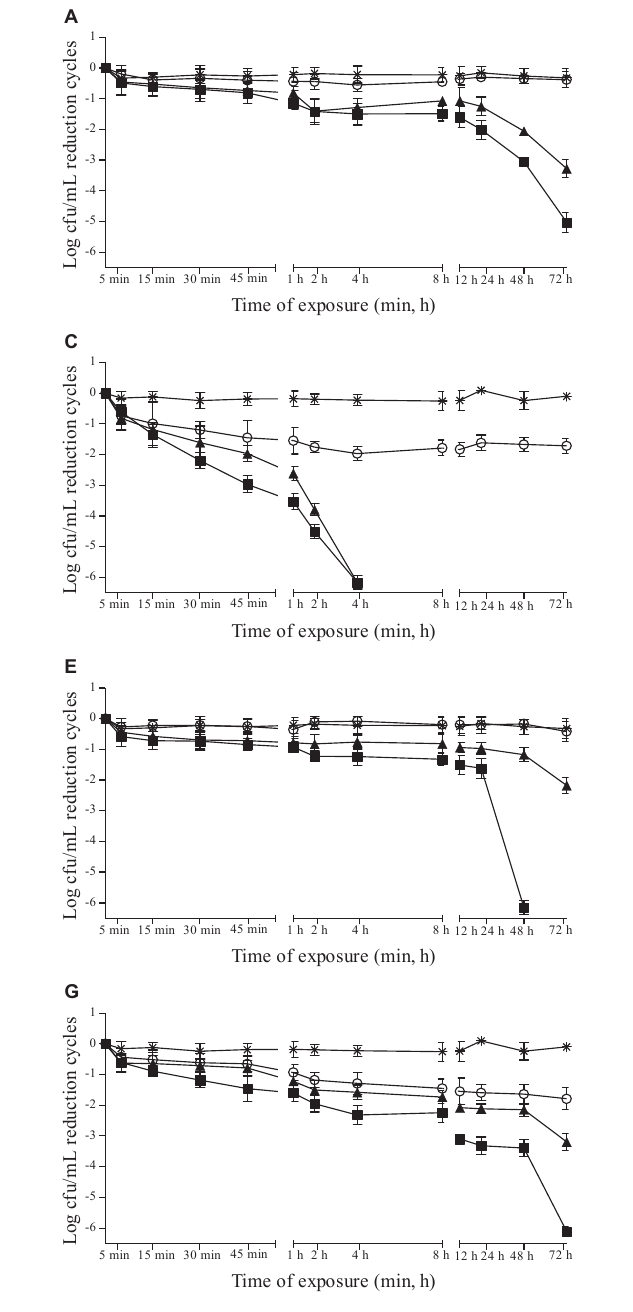
FIGURE 3 | Reduction cycles (log cfu/mL; n = 6) of the counts of C. albicans ATCC 90028 (A,E) , C. tropicalis ATCC 28707 (B,F) , P. anomala ATCC 40101 (C,G) and S. cerevisiae ATCC 2601 (D,H) in mango juice at 4 ± 0.5 ◦ C as a function of the concentration of M. spicata L. essential oil (A–D) at ( (cid:4) ): 3.75 µ L/mL, ( (cid:78) ): 1.875 µ L/mL, ( ◦ ): 0.9375 µ L/mL or M. villosa Huds. essential oil (E–H) . ( (cid:4) ): 15.0 µ L/mL, ( (cid:78) ): 7.5 µ L/mL, ( ◦ ): 3.75 µ L/mL, ( ∗ ) control: 0 µ L/mL. Detection limit of the test: 1 log